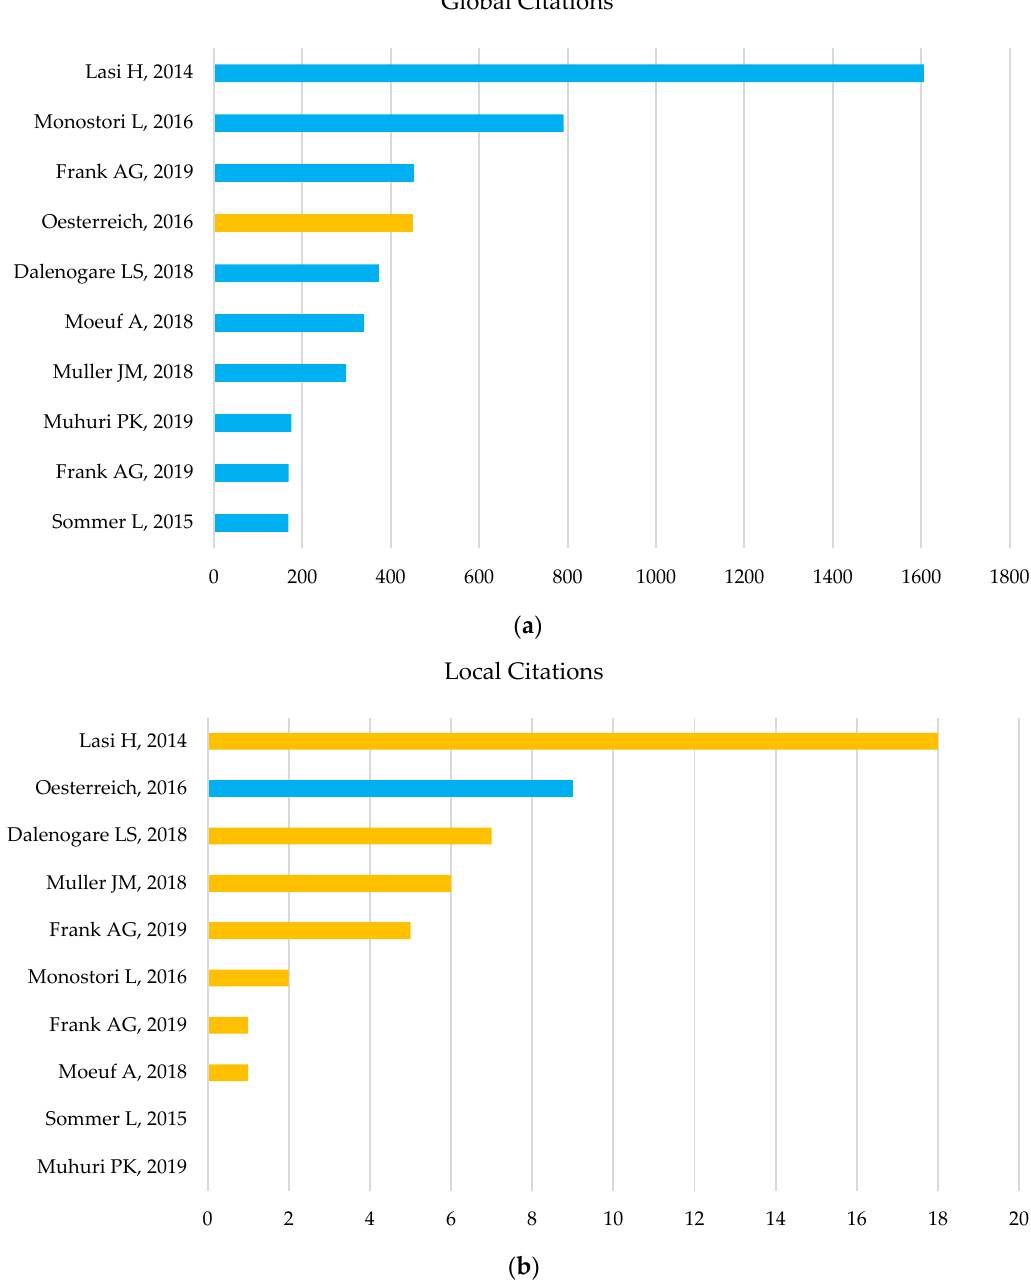
Figure 3. ( a ) Top ten most cited articles (globally) as calculated by Bibliometrix. ( b ) Top ten most cited articles (Locally) as calculated by Bibliometrix.